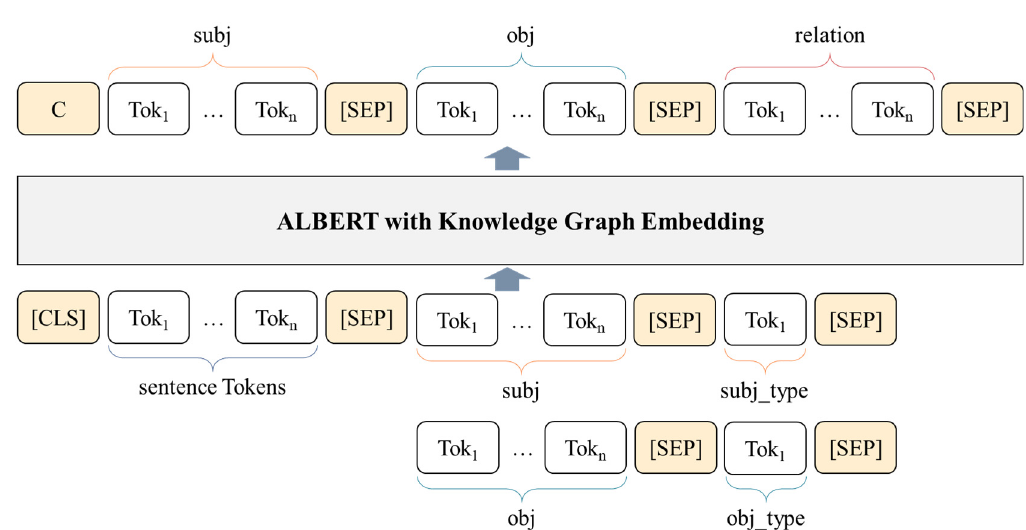
Figure 5. Input and output of the relation extraction model.